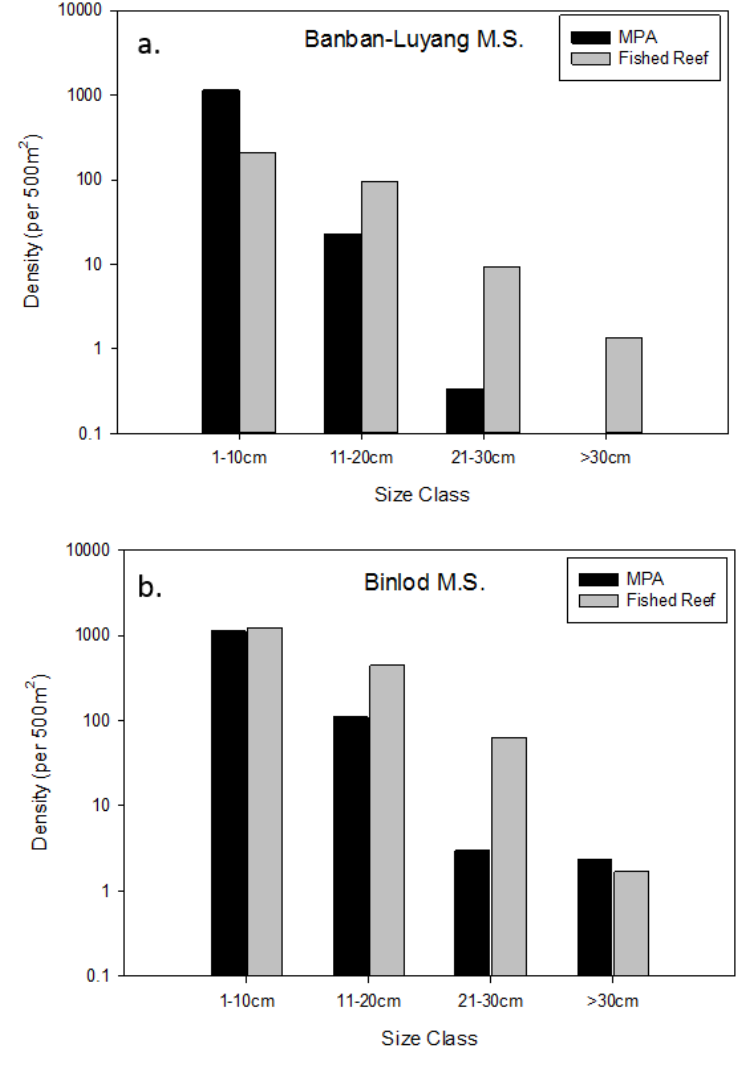
Figure 5. Fish body size frequency distributions from both the ( a ) Banban-Luyang Marine Sanctuary (M.S.) and the ( b ) Binlod Marine Sanctuary, both of which demonstrated a significant shift towards larger fish body sizes in fished reefs compared to fishes within MPAs. Black bars represent the fish density of fishes inside MPAs, while grey bars represent fish density in fished